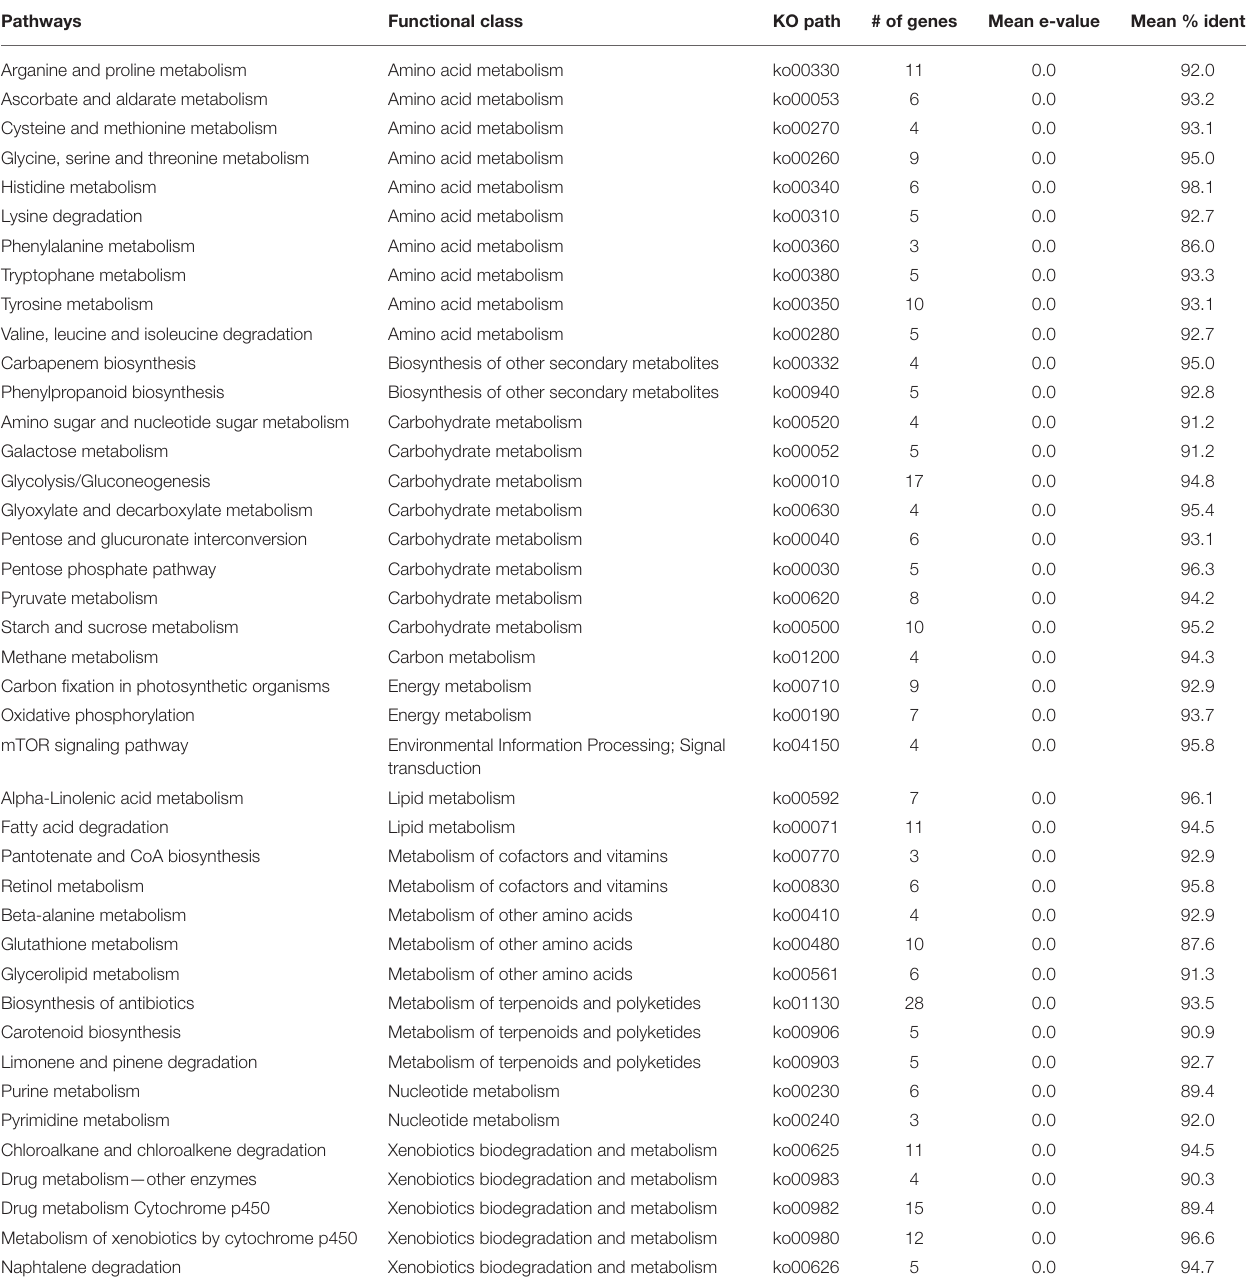
TABLE 2 | Description of key pathways involved in the cross-talk